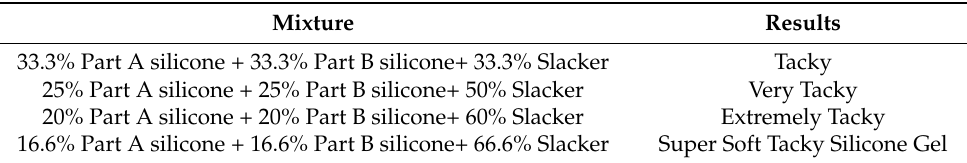
Table 2. Different mixtures of Slacker with silicones in order to obtain different results. As each part corresponds to an equal amount of product